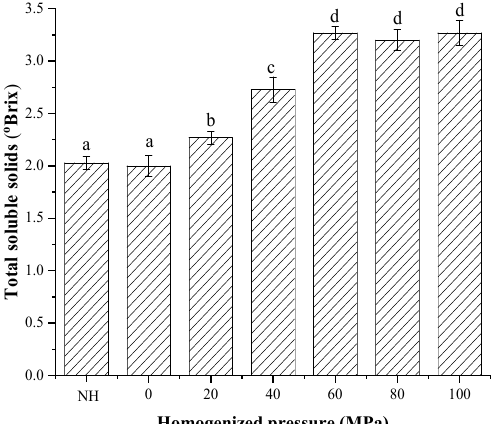
Figure 6. Effect of high-pressure homogenization on the total soluble solids (TSS) content of lily pulp. Different letters in the column indicate that the samples were significantly different ( p < 0.05).